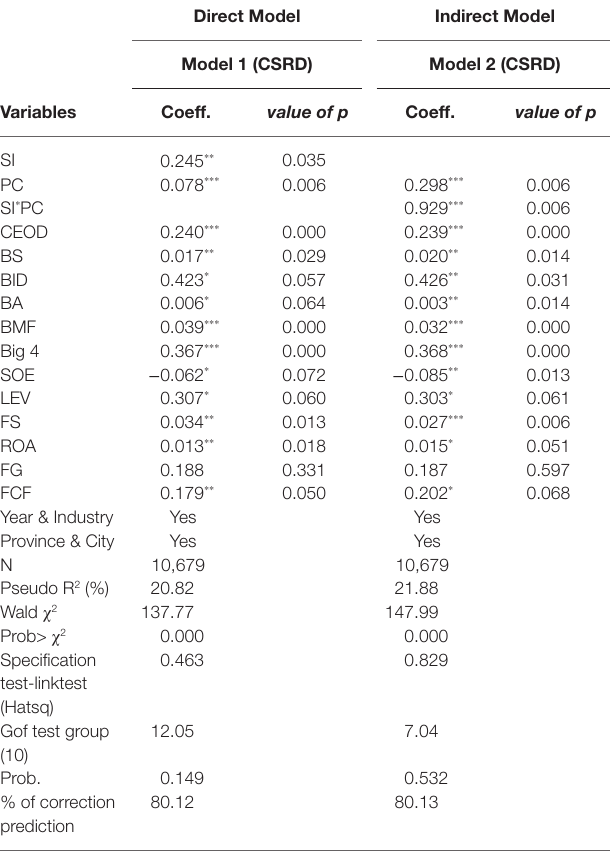
TABLE 5 | Alternative measure of CSR